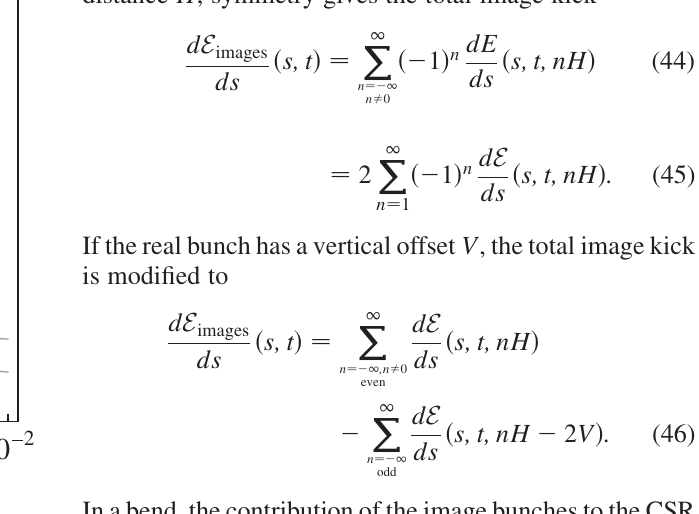
FIG. 6. Similar to Fig. 5, but with the ratio of the average energy of Eq. (32) to Eq. (41), showing that the latter is an excellent approximation at relatively low